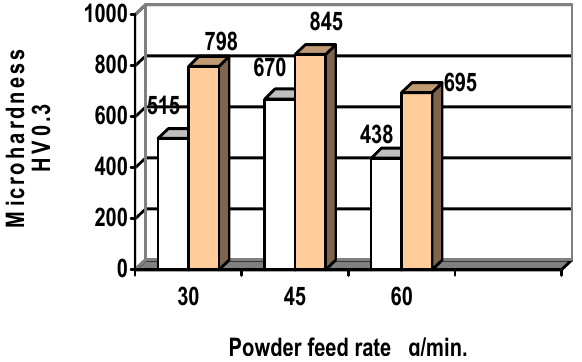
Figure 2 – Microhardness of 75Cr3C2 - 25Ni(Cr) layers Slika 2 – Mikrotvrdo ć a 75Cr3C2 - 25Ni(Cr)